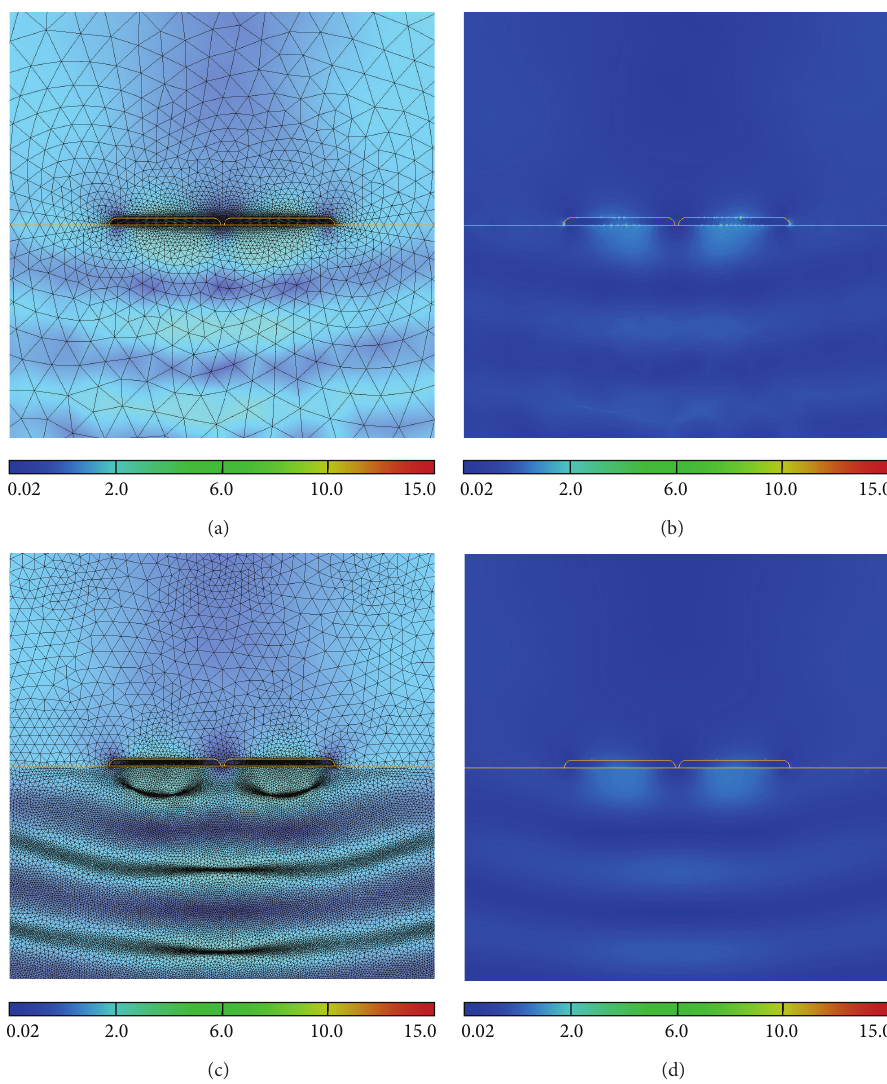
Figure 2: Electric field amplitude for 2 gold nanostripes for the initial (a) mesh and (b) computation and after adaption of the (c) mesh and (d) the field computation,